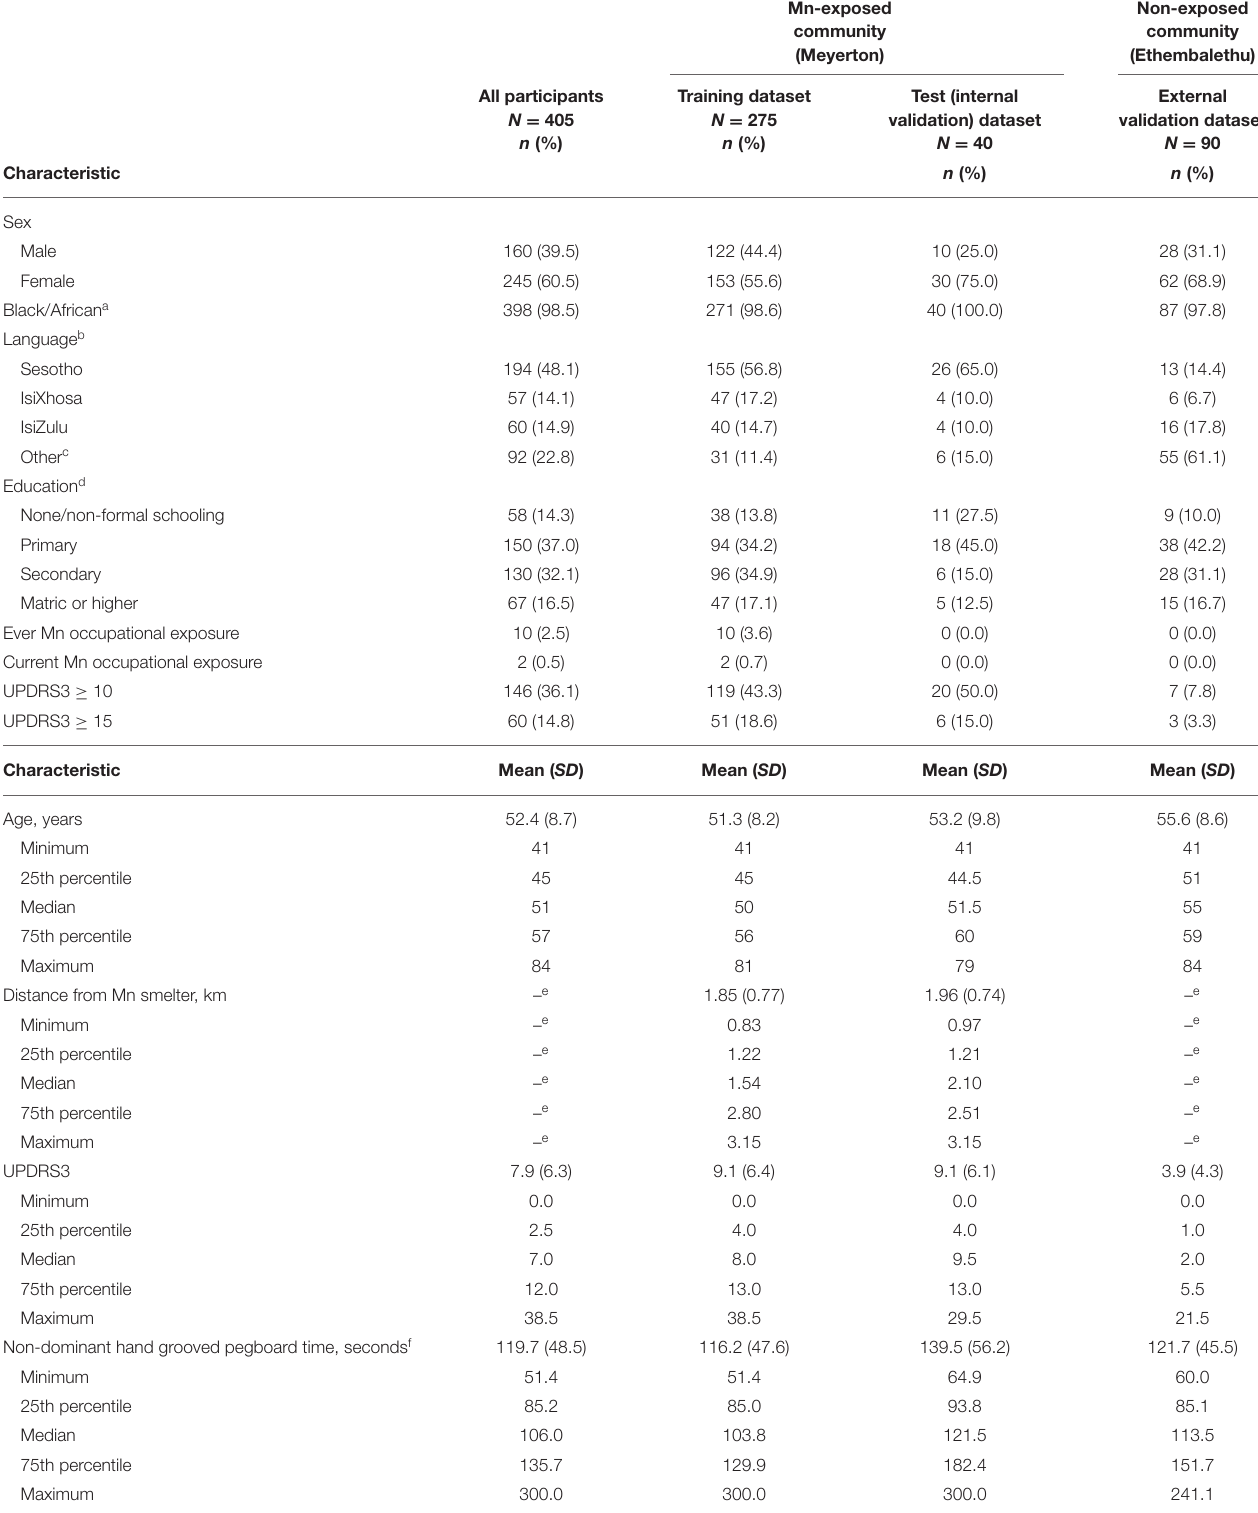
TABLE 1 | Participant characteristics, overall and by environmental manganese (Mn) exposure status, South Africa,